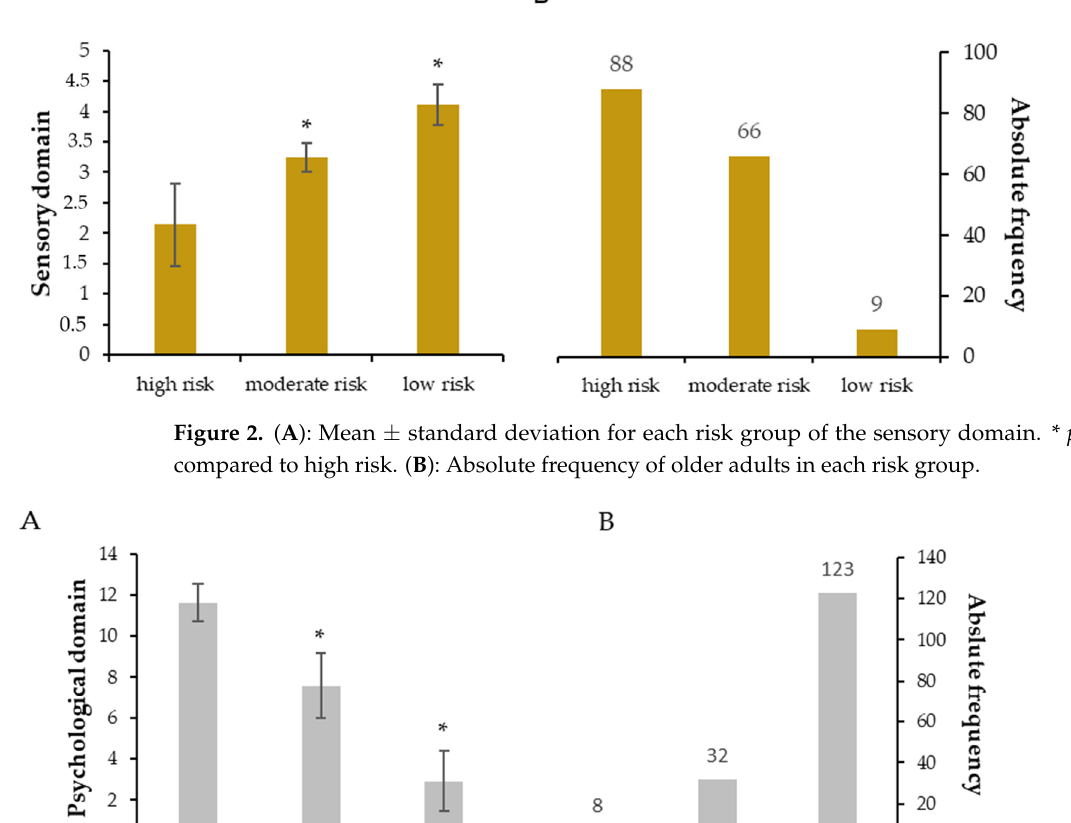
Figure 1. ( A ): Mean ± standard deviation for each risk group of the cognitive domain. * p < 0.001 compared to high risk; #: p = 0.002 compared to moderate risk. ( B ): Absolute frequency of older adults in each risk group .